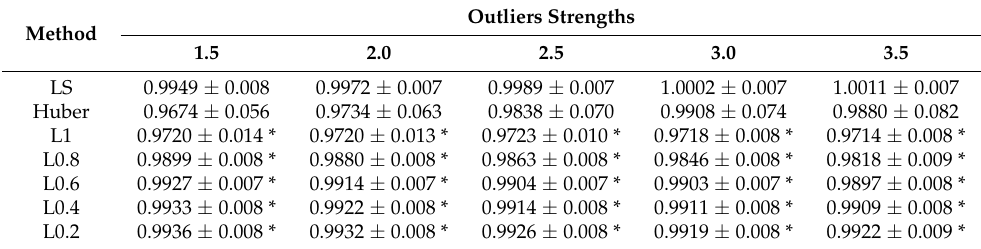
Table 5. Parameter estimation bias of the SISO system with different outlier strengths.